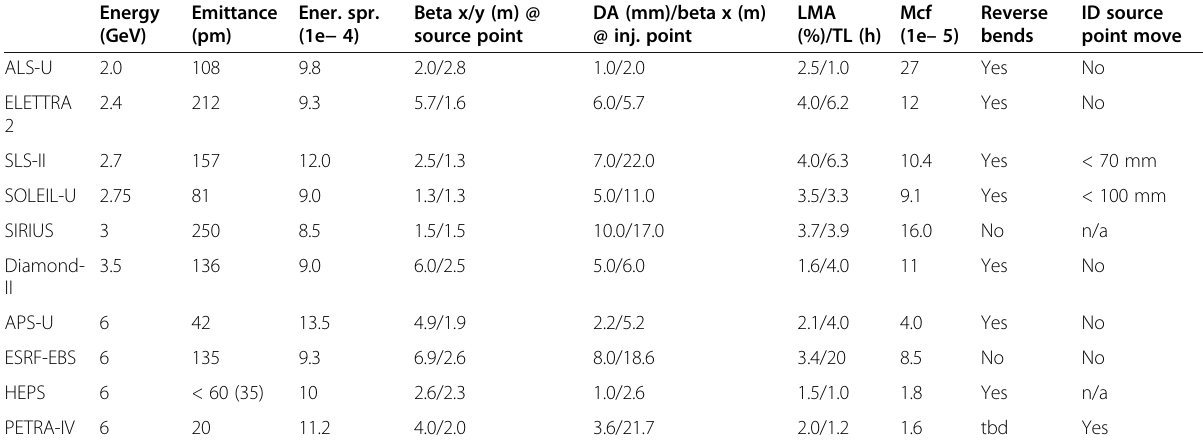
Table 1 Worldwide ongoing 4GSR projects [25]